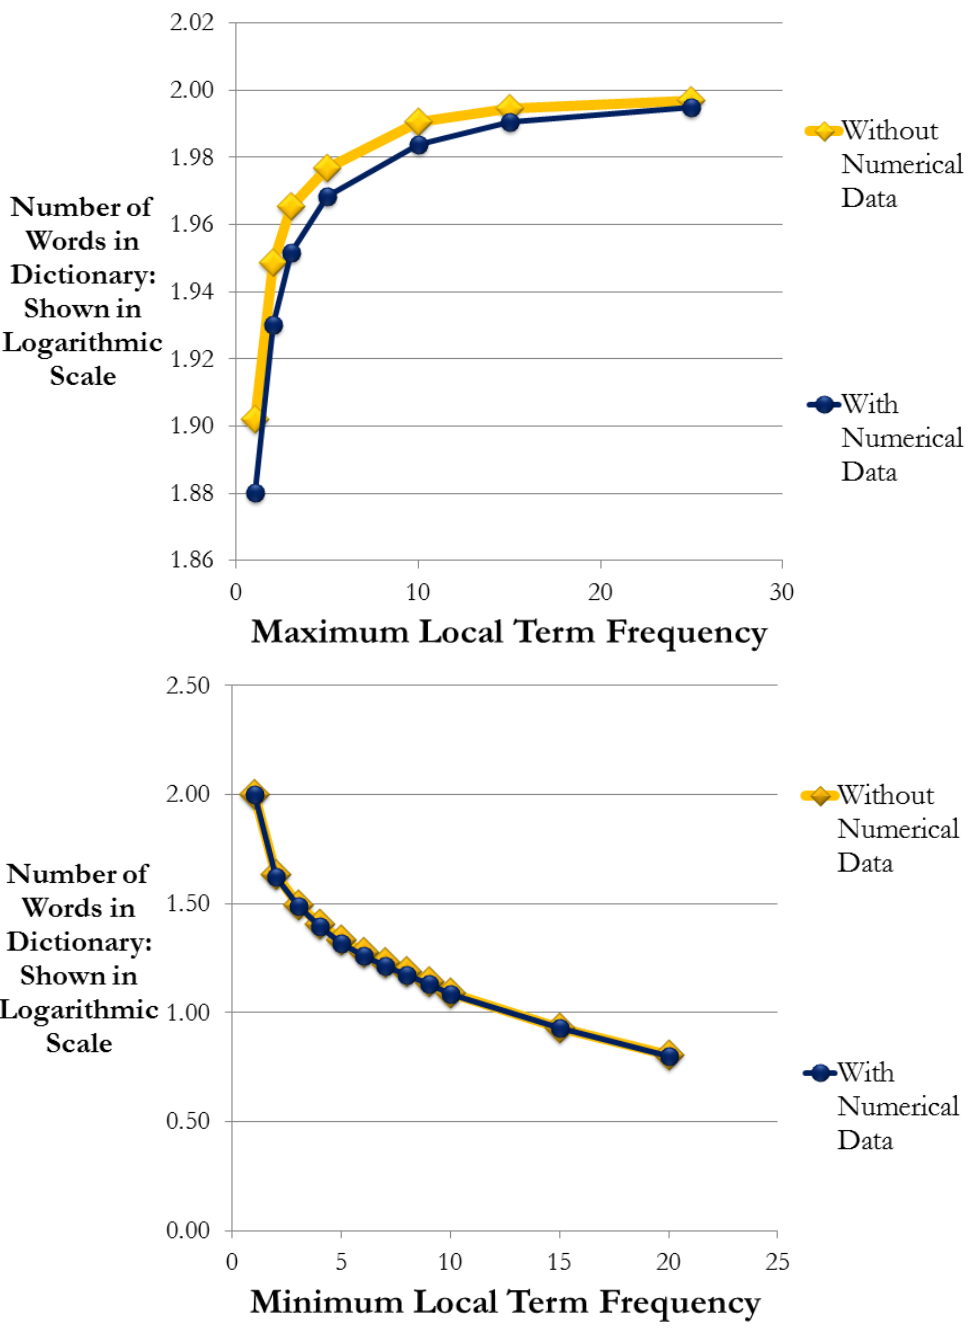
Figure 3. The effects of the percent size of the dictionary as the local thresholds change. The Y-axis represents the percent size of the dictionary in logarithmic scale, base